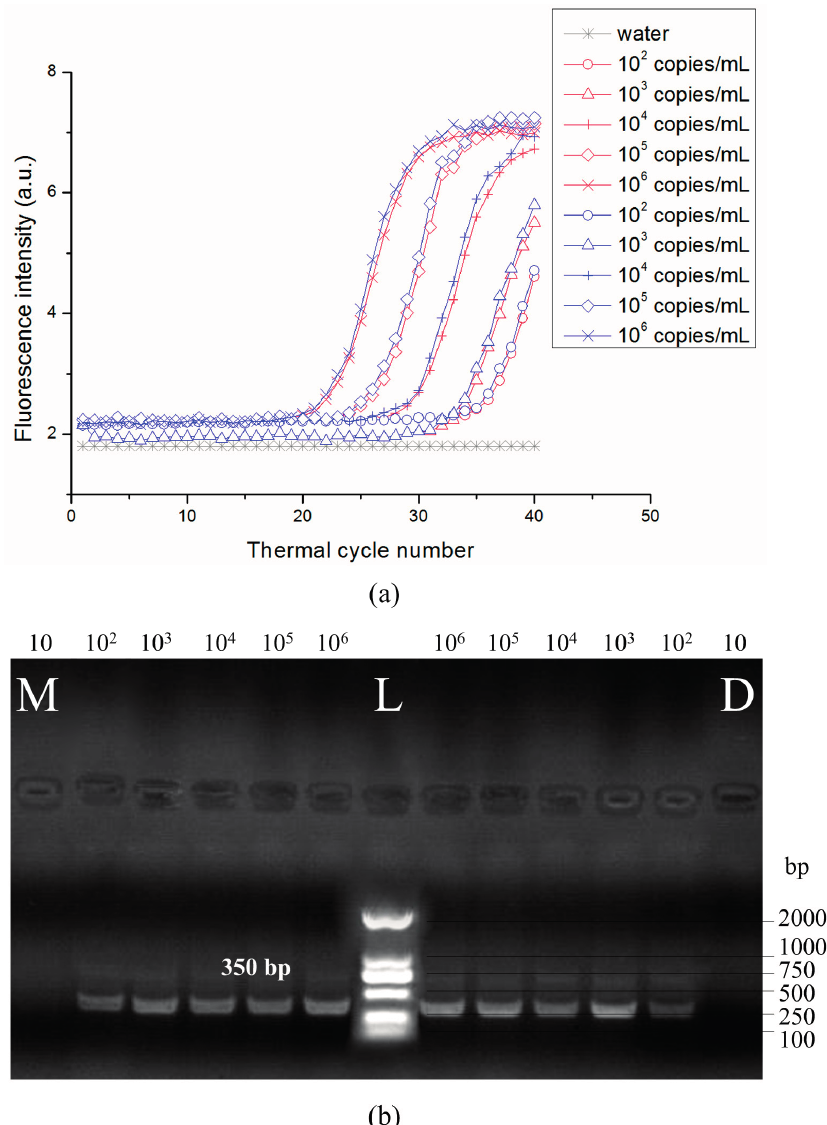
Figure 7. The PCR was conducted under with the optimized PCR protocol (3-s denaturation, 10-s annealing and 5-s extension). ( a ) Fluorescence intensity vs. cycle number for the detection of HBV gene (350 bp) with known initial concentrations of template (10 2 –10 6 copies/mL) (blue lines: commercial PCR machine; red lines: disc PCR); ( b ) Gel electropherograms for detection of HBV and template with known initial concentrations (10–10 6 copies/mL). (L: DNA marker; M: commercial PCR machine; D: disc